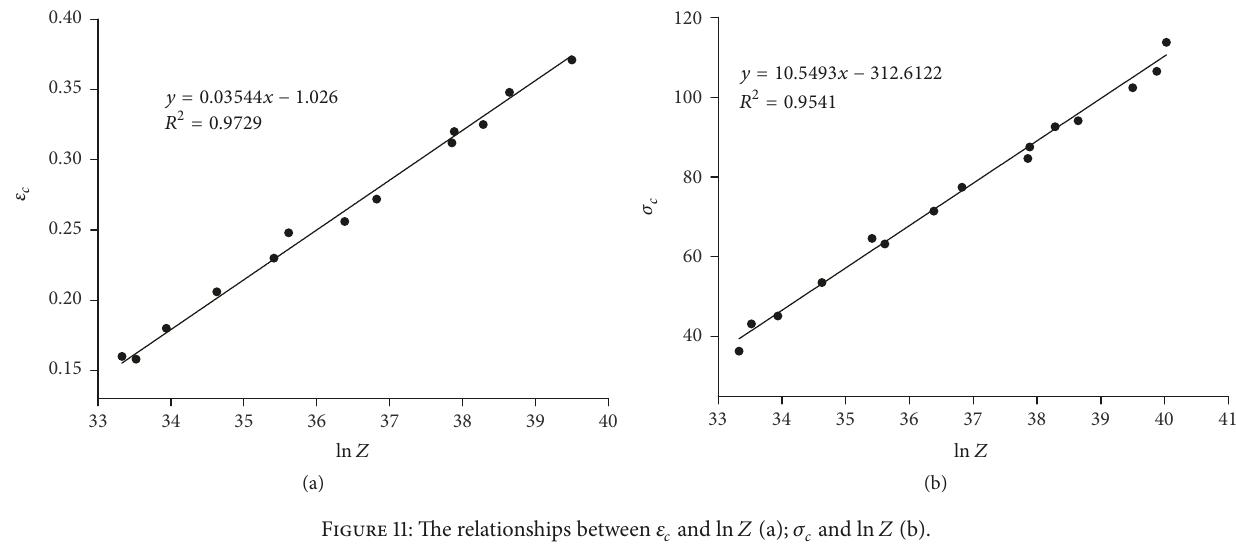
Figure 11: The relationships between 𝜀 𝑐 and ln 𝑍 (a); 𝜎 𝑐 and ln 𝑍 (b).